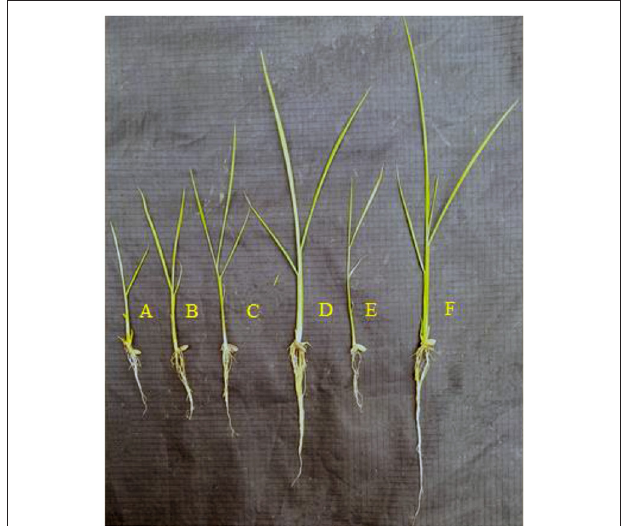
FIGURE 3 | Growth promotion of rice treated with five selected diazotrophic PGP bacteria. (A) Negative control. (B) IHK-1. (C) IHK-3. (D) IHK-13. (E) IHK-15. (F) IHK-25.